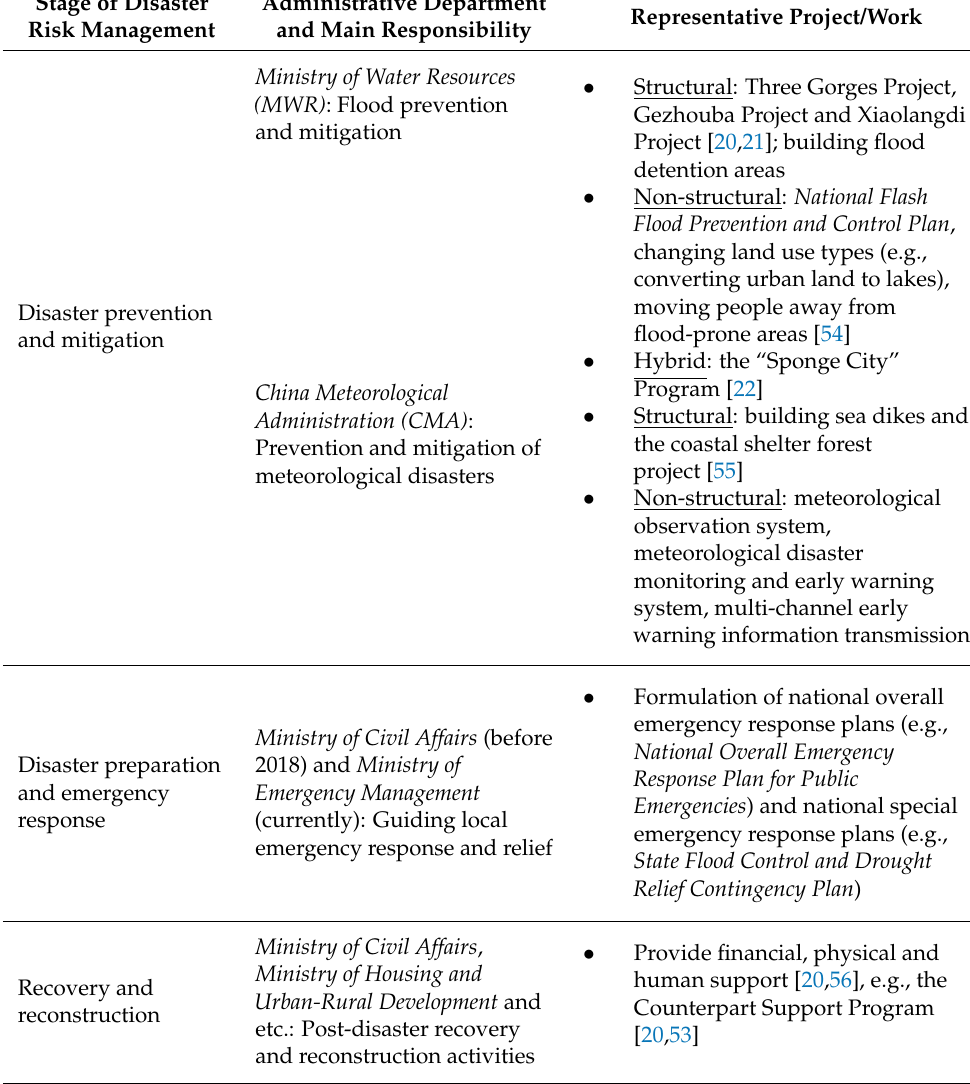
Table 2. Working mechanisms of flood-related disaster risk